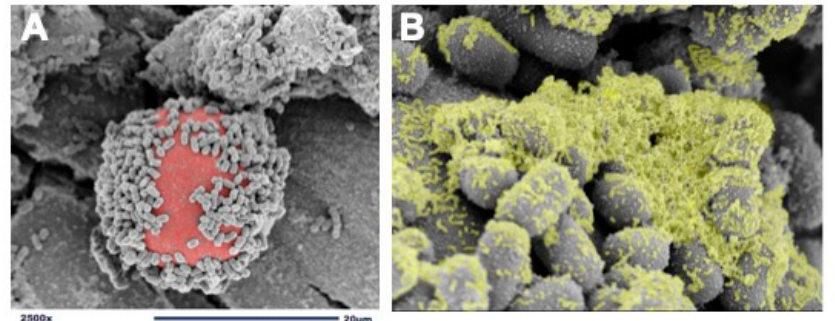
Figure 1. Adherence of L. reuteri to dextranomer microspheres. ( A ) scanning electron microscopy (SEM) image demonstrating the adherence of L. reuteri to the surface of a biocompatible dextranomer microsphere (DM; red); ( B ) magnified SEM image demonstrating the production of biofilm (green) by L. reuteri adhered to a sucrose-loaded